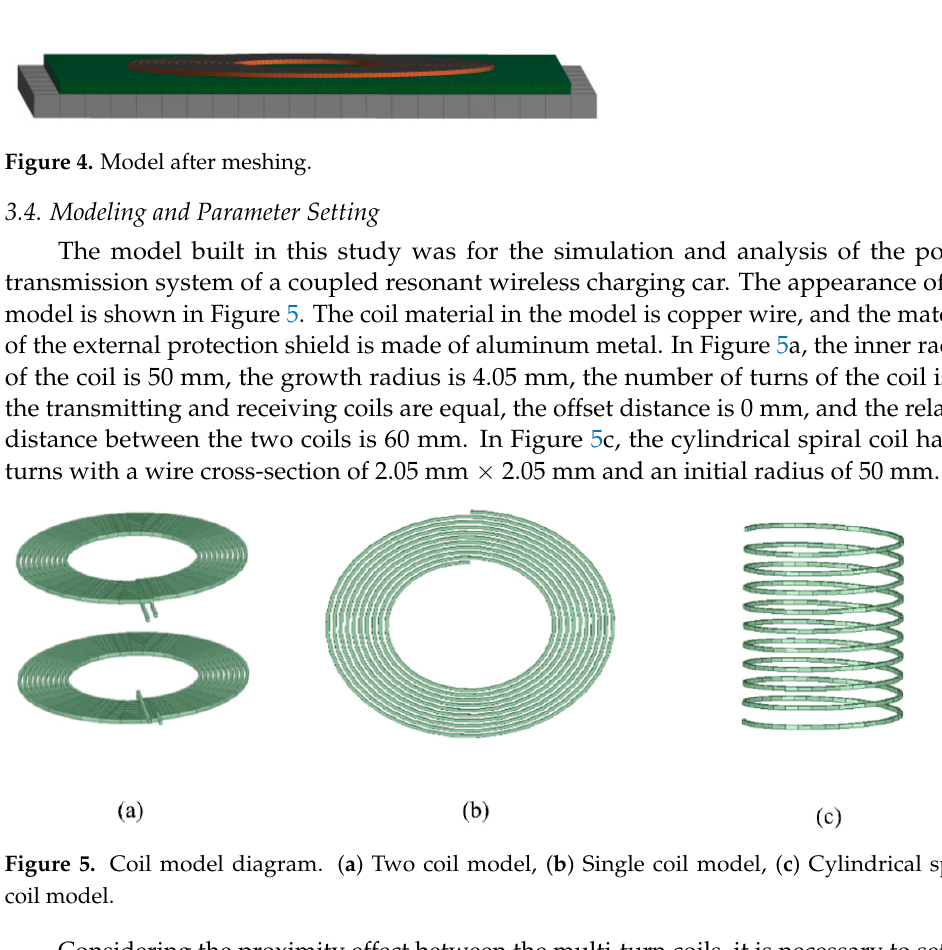
Table 2. Material Table 2. Material parameters.